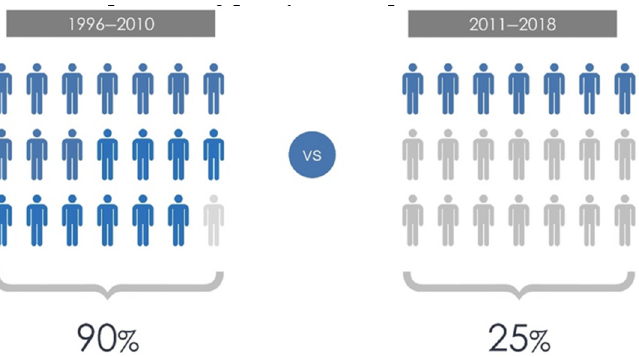
Figure 13. Percentage of articles published in credible journals before and after the introduction of the open-access model in Uzbekistan.